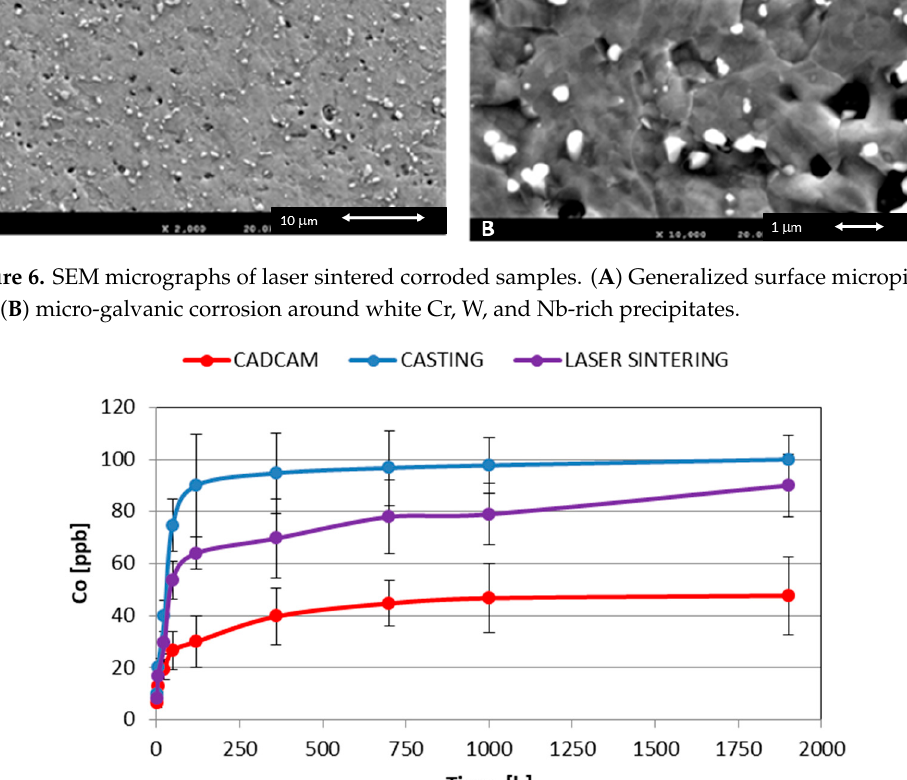
Figure 6. SEM micrographs of laser sintered corroded samples. ( A ) Generalized surface micropitting